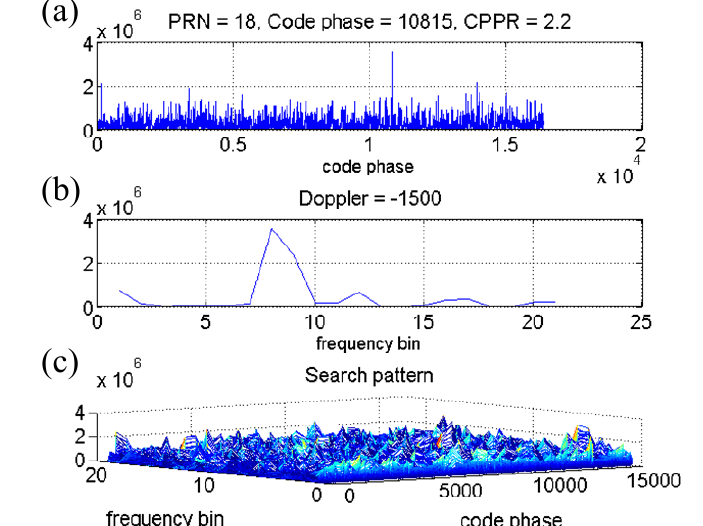
Figure 10. (a) The correlation distribution versus the code delay samples at the frequency bin with maximum correlation peak. (b) The correlation distribution versus the frequency bin at the code delay sample with maximum correlation peak. (c) The search pattern of the PRN 18 of the collected indoor signal in the acquisition